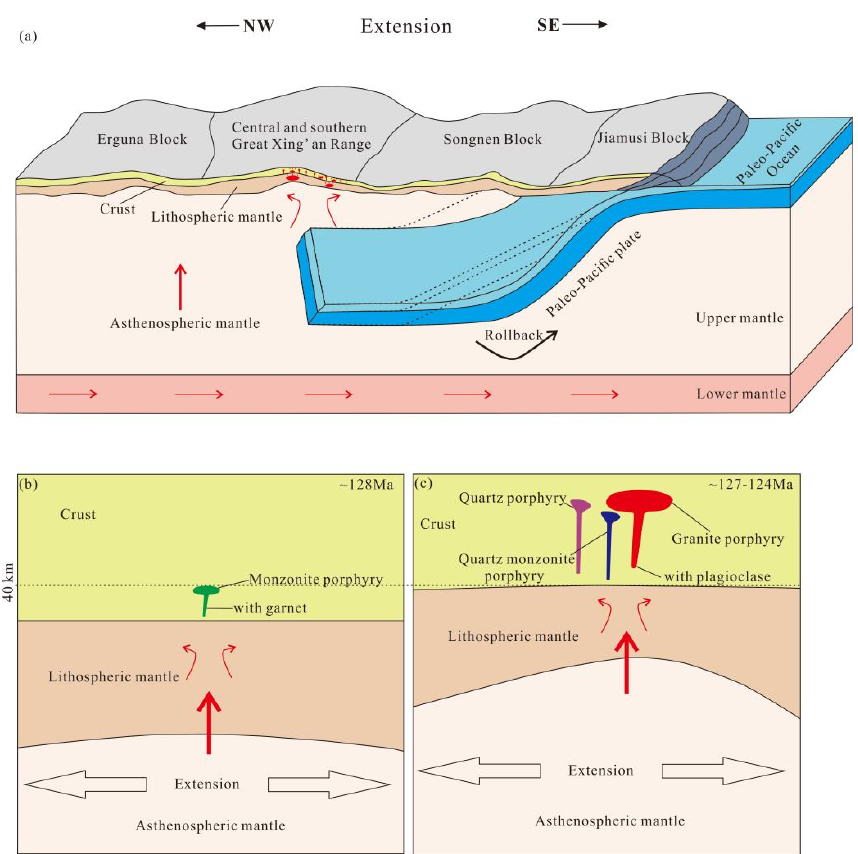
Figure 13. ( a ) Schematic model for the Early Cretaceous geodynamic processes in the central-southern GXR (modified from Tang et al. [75]); ( b ) Conceptual model for the formation of the monzonite porphyry (modified from Feng et al. [26]); ( c ) Conceptual model for the formation of the quartz monzonite porphyry, quartz porphyry, and granite porphyry rocks (modified from Feng et al. [26]).